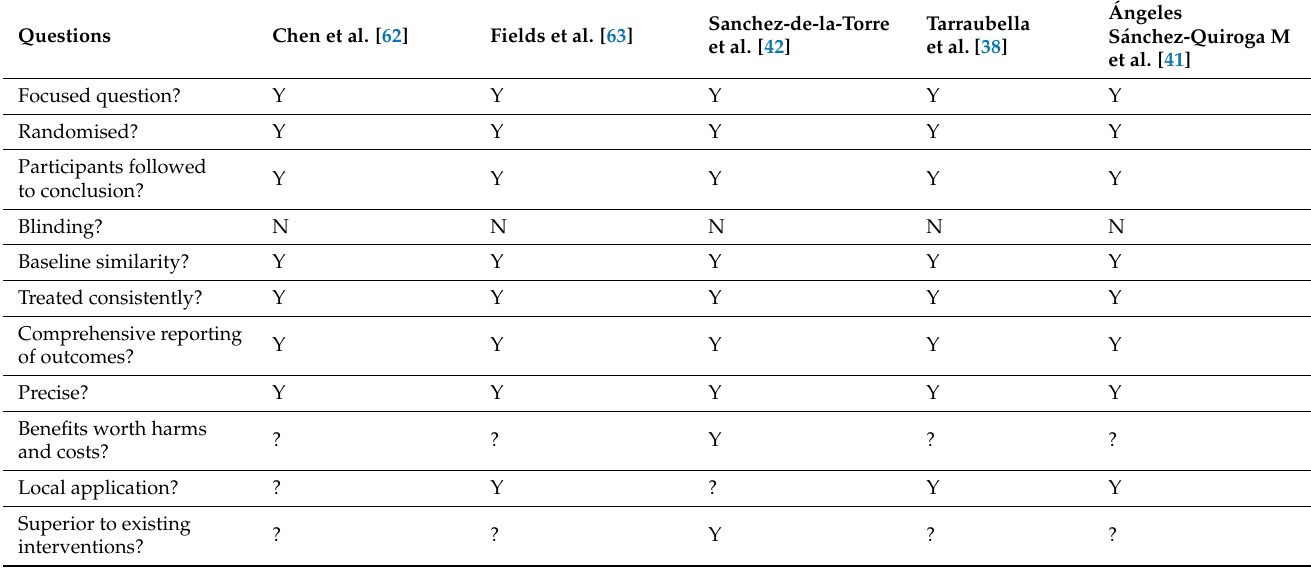
Table A2. Randomised controlled trial